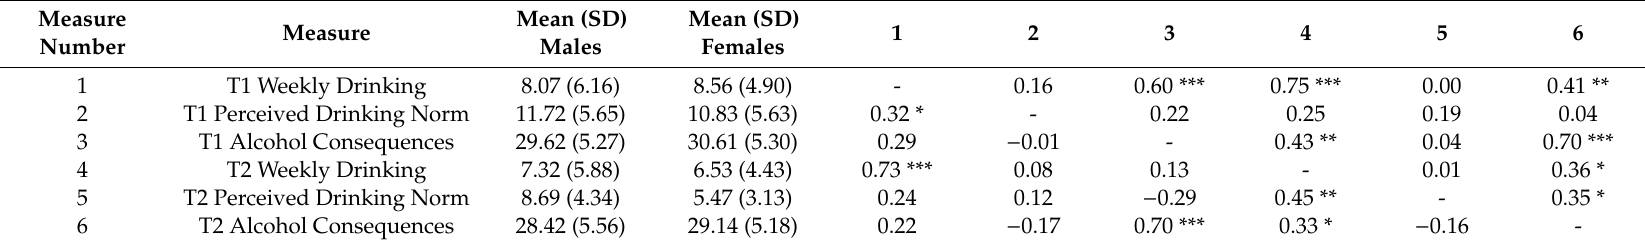
Table 4. Correlation matrix of variables for males ( n = 34) and females ( n = 36).